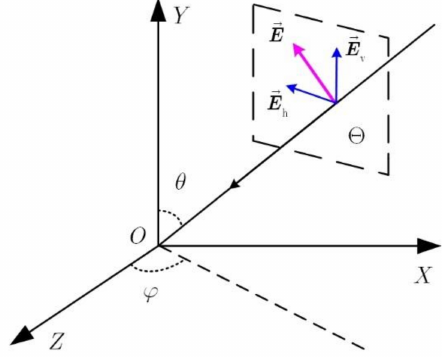
Figure 1. Transverse electric